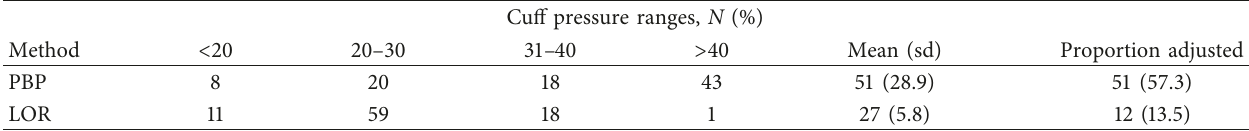
Table 2: ETT cuff pressure estimation by the PBP and LOR